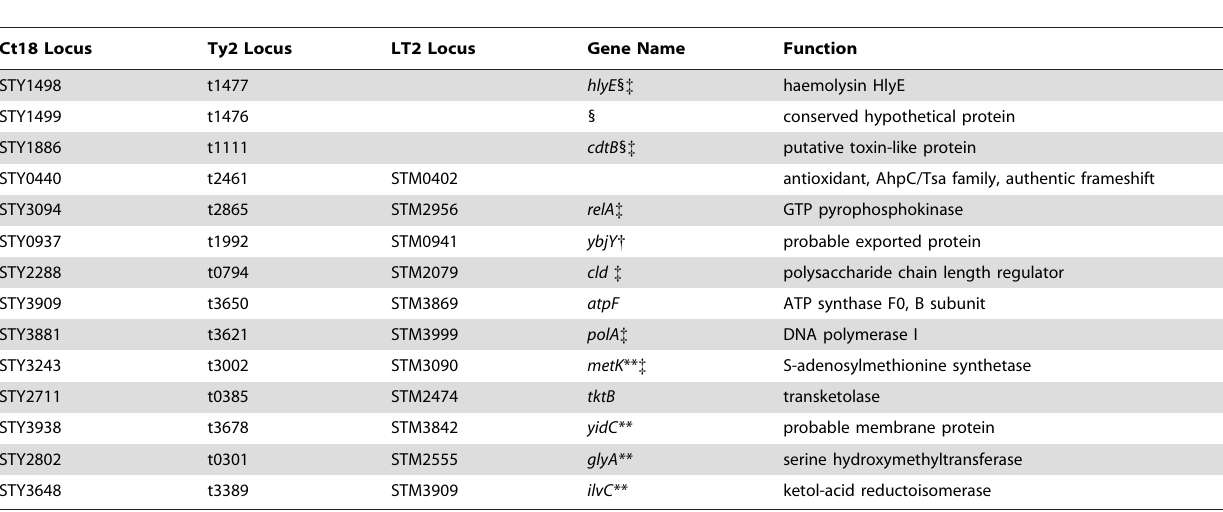
Table 3. PhoP-dependent proteins identified in our proteomic analysis in S. Typhi and not in S. Typhimurium*.